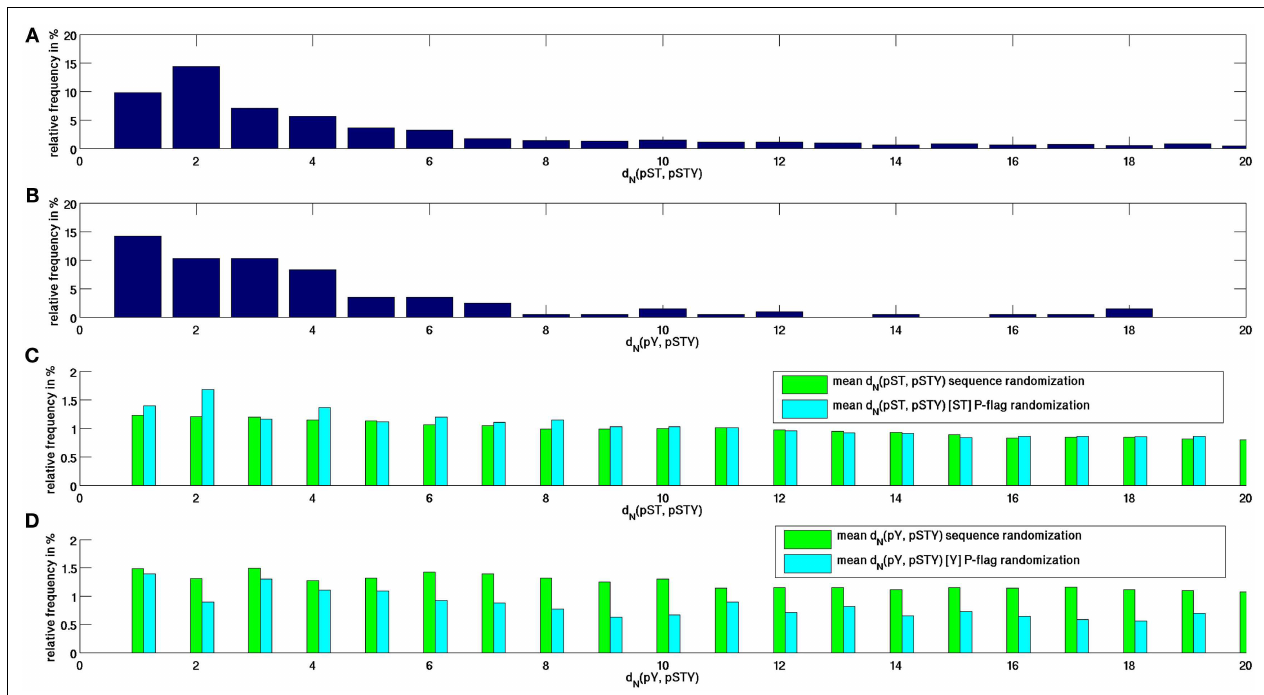
sequence-randomized protein sequences averaged over 100 repeat runs for nearest pST and pSTY distances. (D) Similary for pY, pSTY distances. In P-flag, phosphorylation signals were randomly redistributed among the existing serines and tyrosines, whereas in sequence-randomized runs, the entire protein sequence was